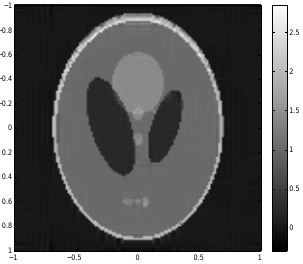
Figure 20. Chebyshev reconstruction of the Shepp-Logan brain phantom on [128